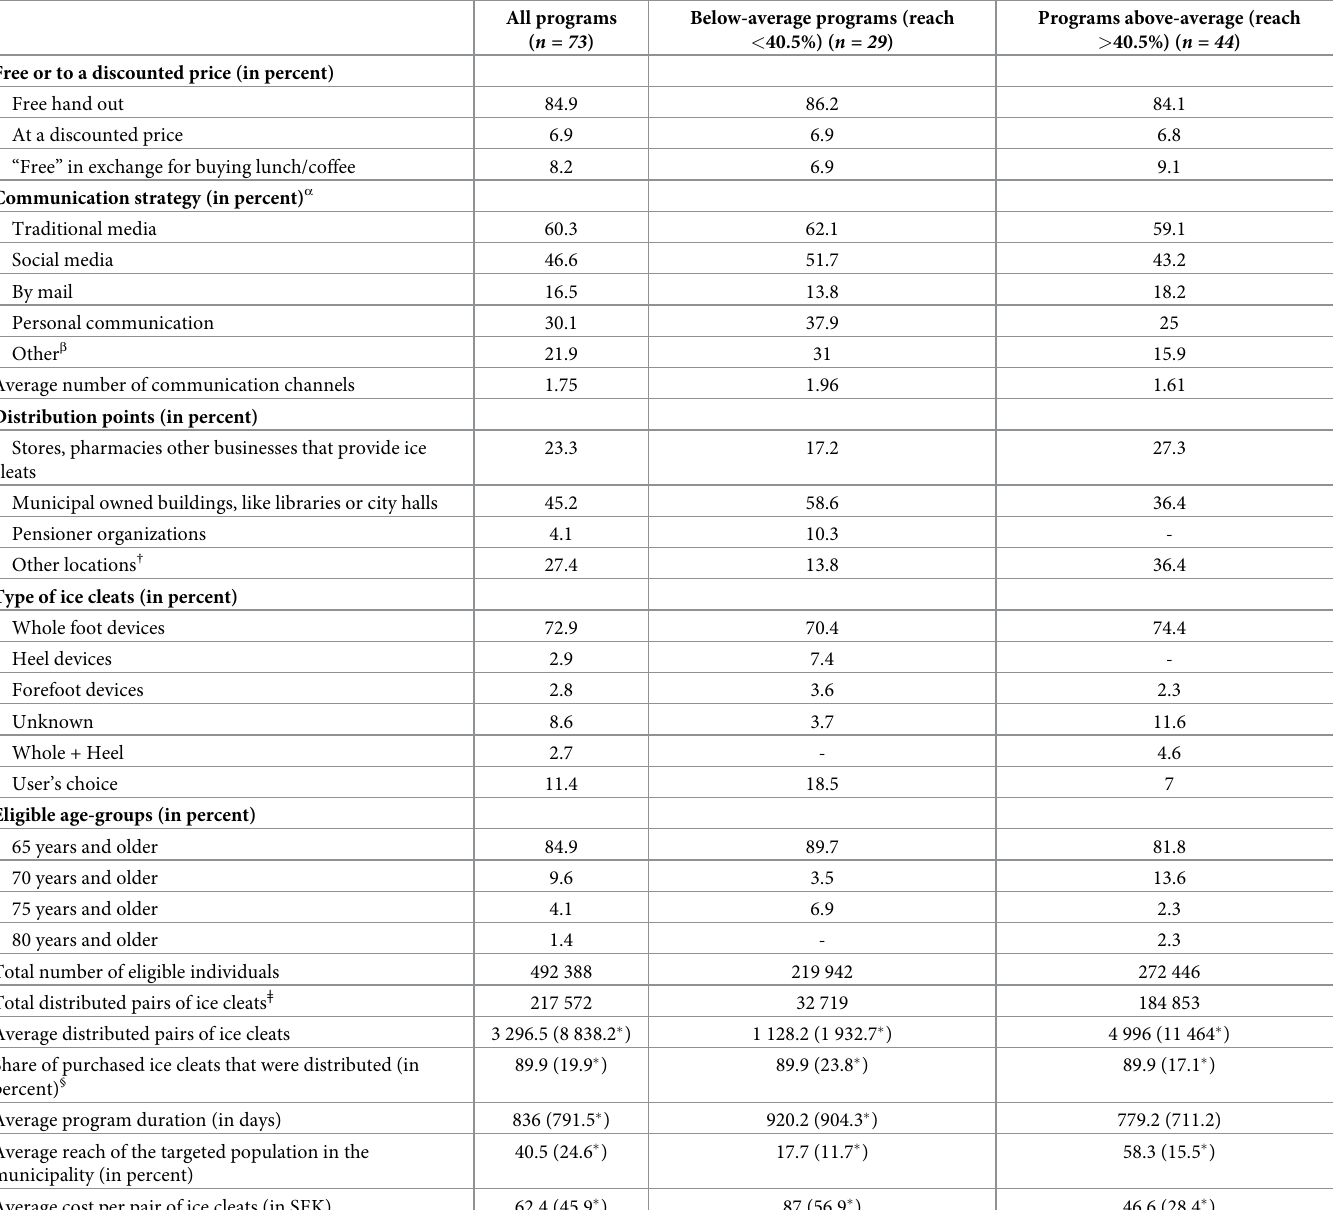
Table 1. Descriptive statistics of municipal ice cleat programs for older adults based on a survey of 228 (out of 290) municipalities in